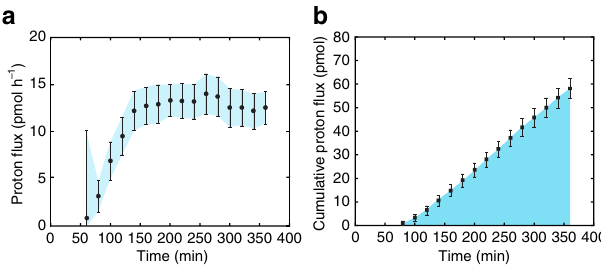
Figure 2 | Calculated proton flux from the reduction in environmental pH. ( a ) Time series of proton flux during chamber formation and ( b ) the corresponding cumulative proton flux (Specimen no. 3 in Table 1). These estimates are based on analysis of the pH image series by theoretical fitting of the decreased pH as a function of distance from the foraminifer. Error bars indicate